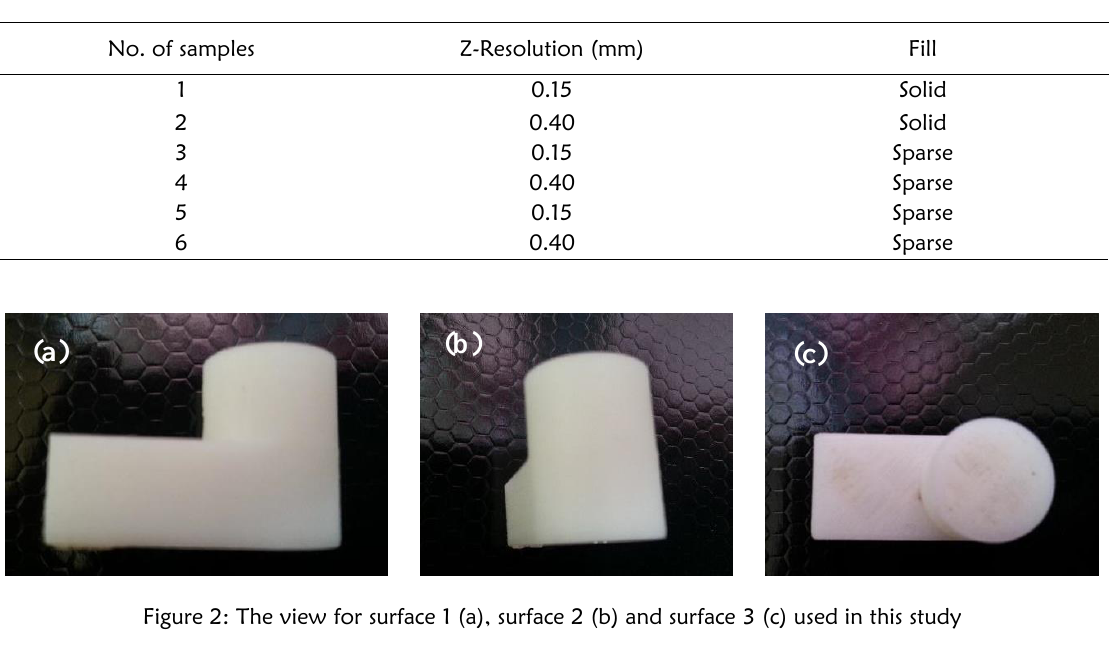
Table 1: Types of Fill and Z-Resolution parameters applied on samples